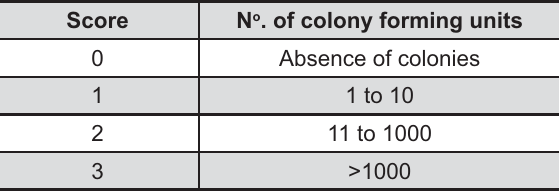
Figure 3- Score used to count the colony forming units Table 1- Score for colony forming units (cfu), descriptive analysis and Mann-Whitney statistical Groups